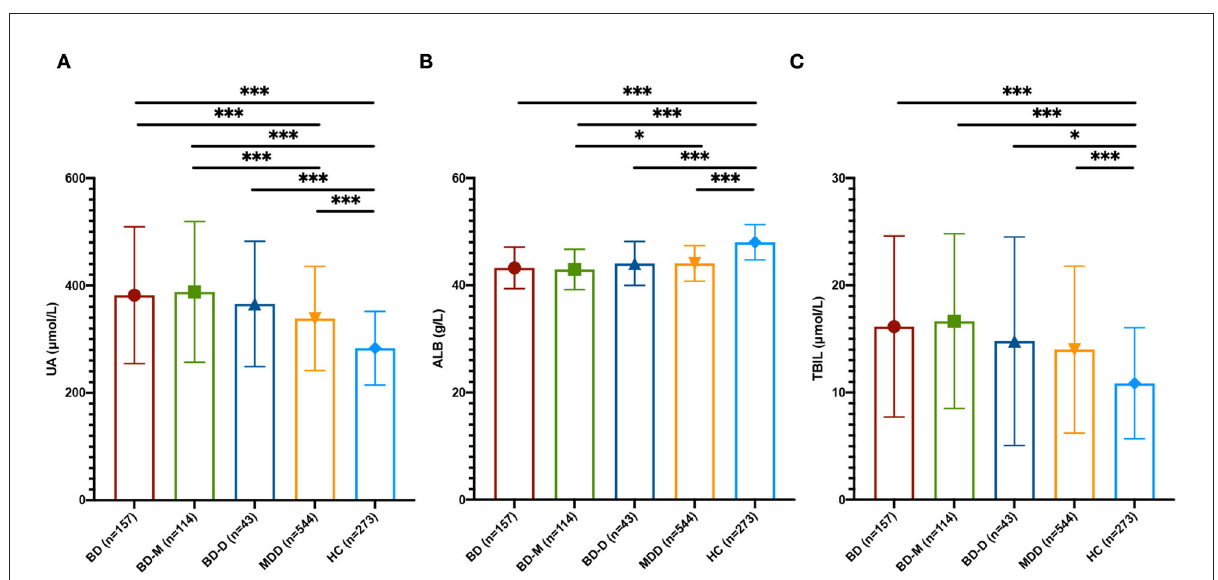
FIGURE1 Peripheral non-enzymatic antioxidants at baseline among BD, MDD, and HC. (A) UA levels among BD, MDD, and HC groups. (B) ALB levels among BD, MDD, and HC groups. (C) TBIL levels among BD, MDD, and HC groups. UA, uric acid; ALB, albumin; TBIL, total bilirubin; BD, bipolar disorder; BD-M, bipolar disorder with mania/hypomania/mixed episode; BD-D, bipolar disorder with depression episode; MDD, major depressive disorder; HC, healthy control; * p < 0.05; *** p < 0.001.